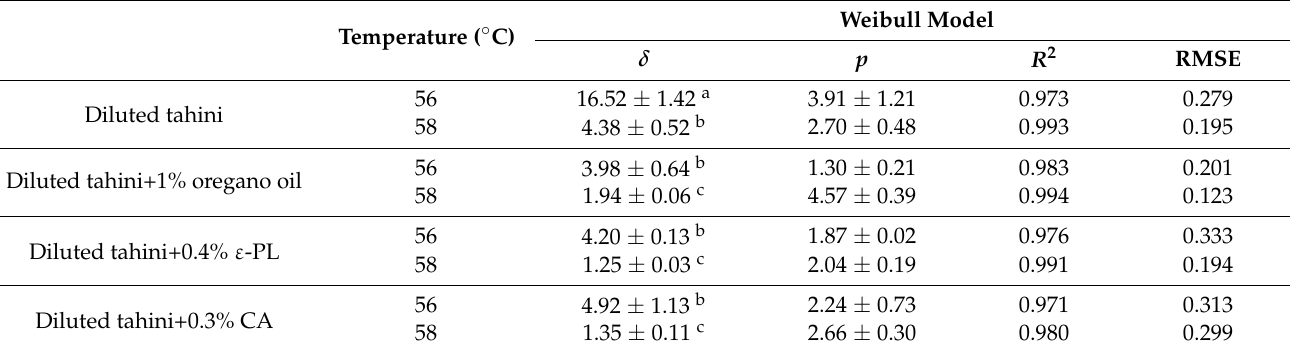
Table 5. δ - and p -values of the Weibull model for thermal inactivation combined with antimicrobials against S. montevideo CICC21588 inoculated into diluted